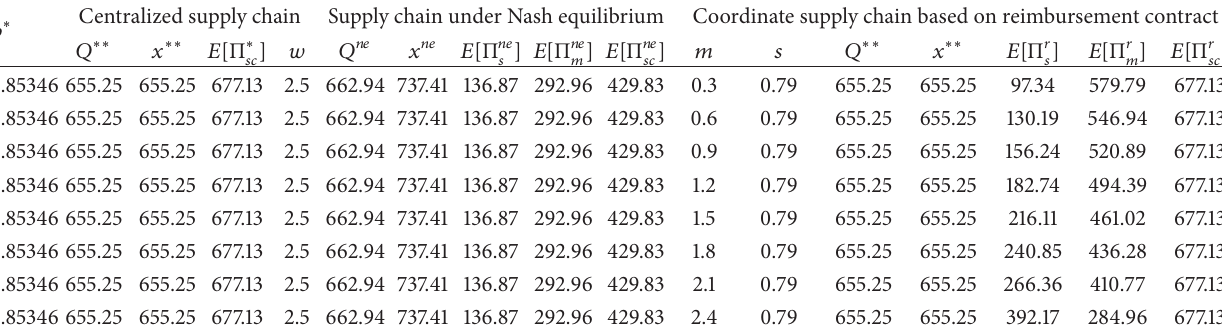
Table 3: Comparison of supply chain under different